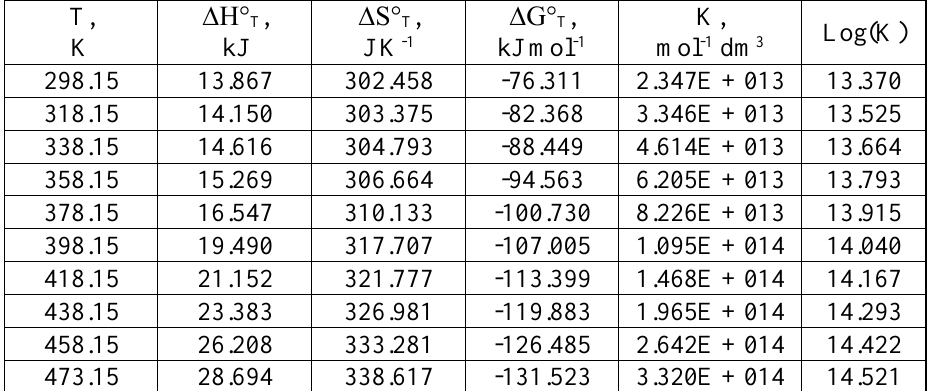
Table 3. Thermodynamic quantities for equation (3) calculated using the HSC Chemistry program (HSC version